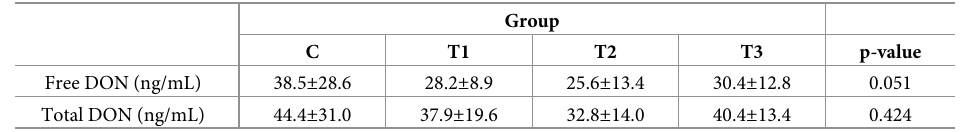
Table 10. Total and free DON levels in urine.